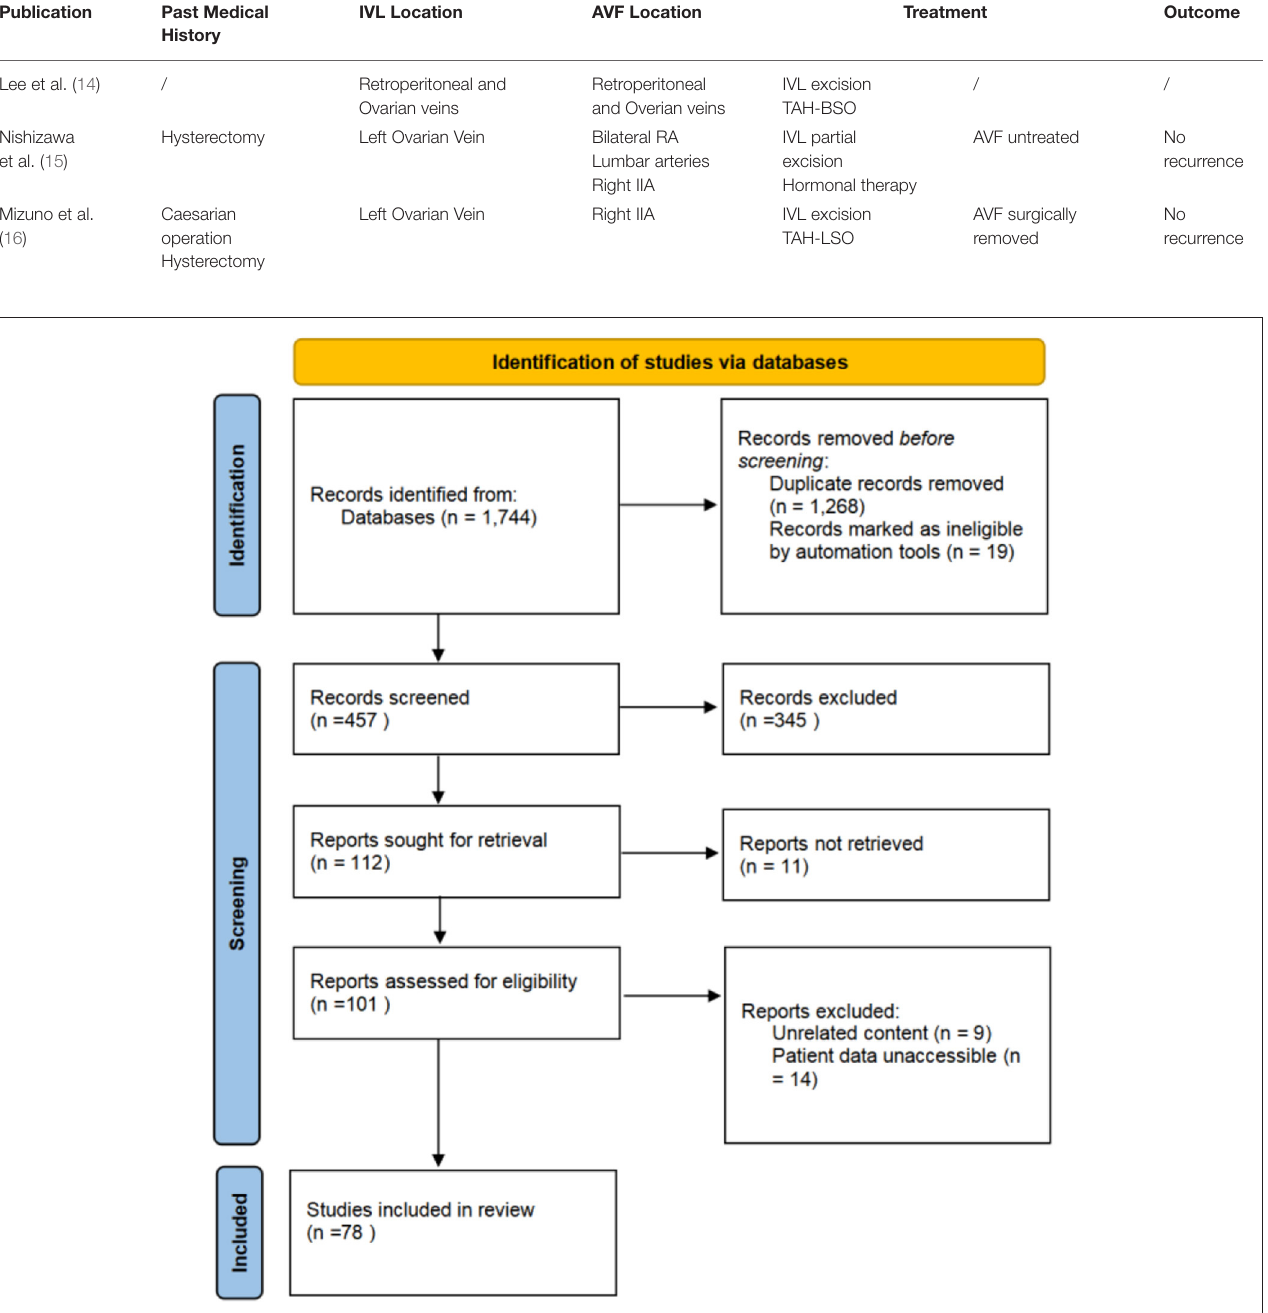
TABLE 1 | Review of intravenous leiomyomatosis (IVL) combined with arteriovenous fistula (AVF).